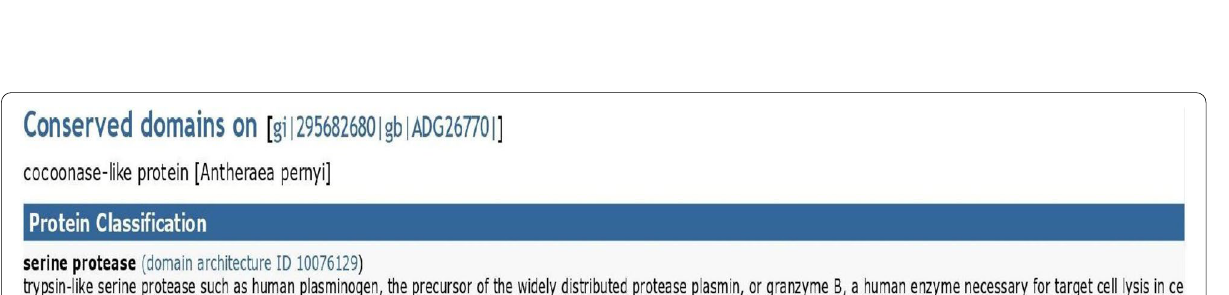
Fig. 10 a Superimposed three-dimensional structure model of template ApCoc (red) and target AmCoc (blue). b Pairwise alignment for ApCoc protein sequence and ApCoc protein sequence with ClustalW